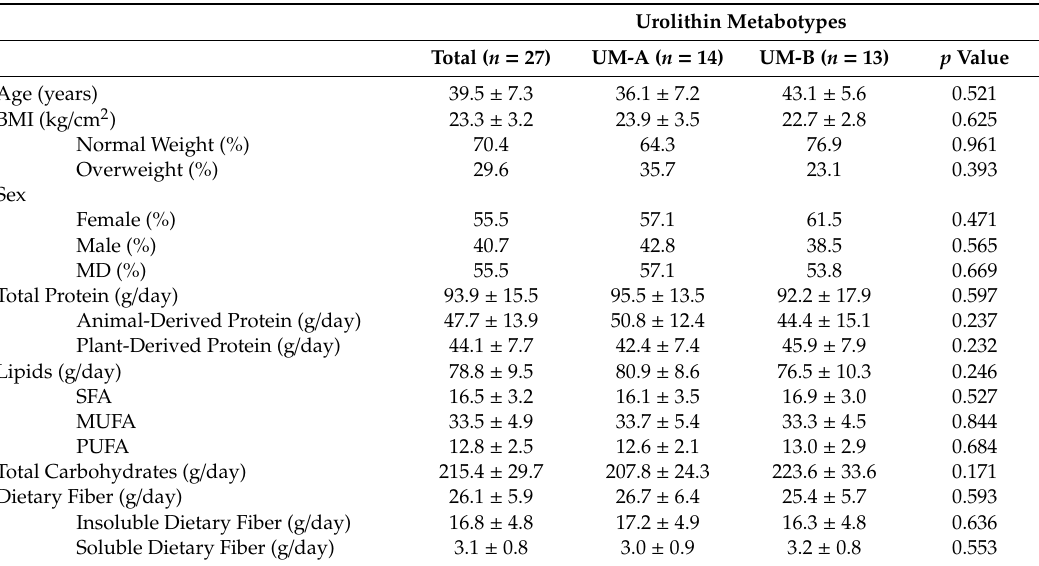
Table 1. Clinical and nutritional characteristics of the